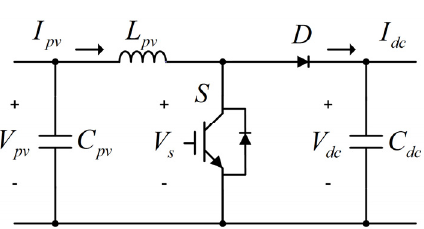
Figure 2. DC/DC boost